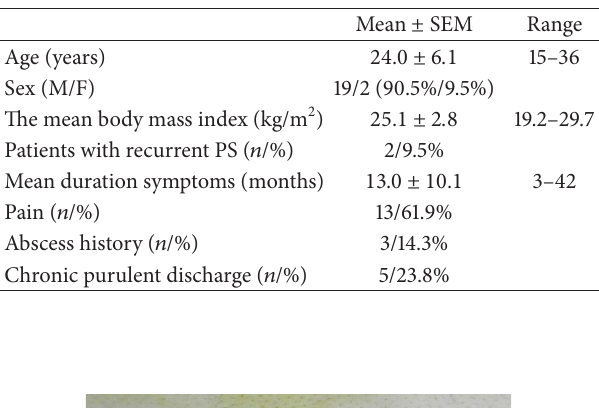
Table 1: Characteristics of patients.